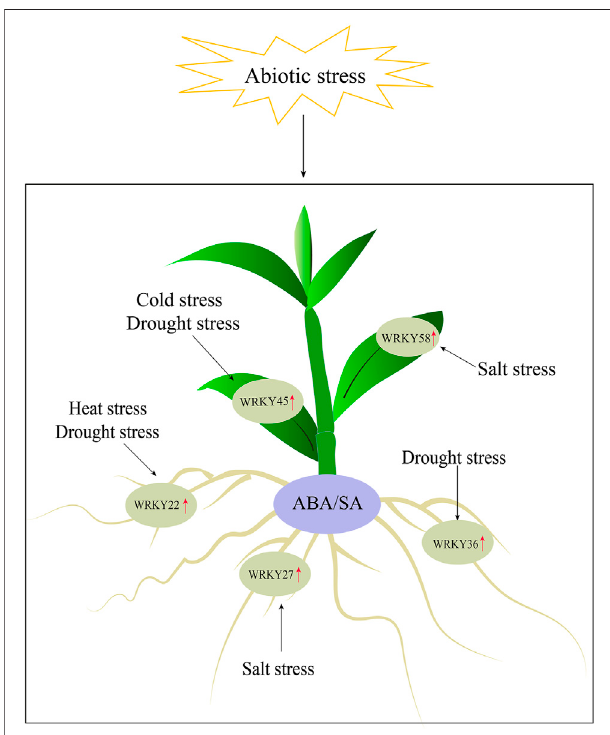
FIGURE 8 | Model of the fi ve DcWRKY genes responding to abiotic